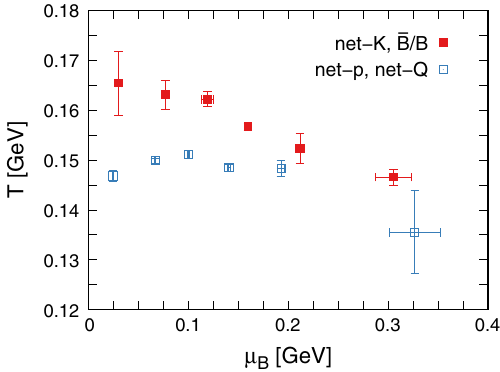
Fig. 2 Chemical freeze-out conditions for T and μ B determined for √ s NN = 200 , 62 . 4 , 39 , 27 , 19 . 6 , 11 . 5 GeV (from the beam energies left to right). The red, solid squares show the results determined in this work from the combined analysis of lowest-order net-kaon fluctuations, ¯ B / B yield ratios. The error bars correspond to the bands σ 2 / M K , and K in the fits shown in Fig. 1. The blue, open squares depict the freeze-out conditions reported in [13] which were determined from a combined analysis of lowest-order net-proton and net-electric charge fluctuations